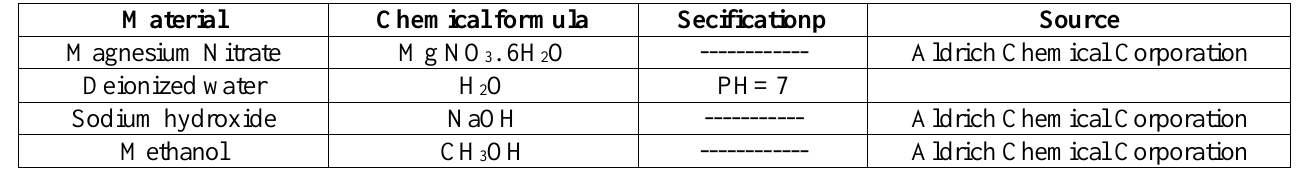
Table 2: Material used in the manufacture of MgO- Nanomaterials.